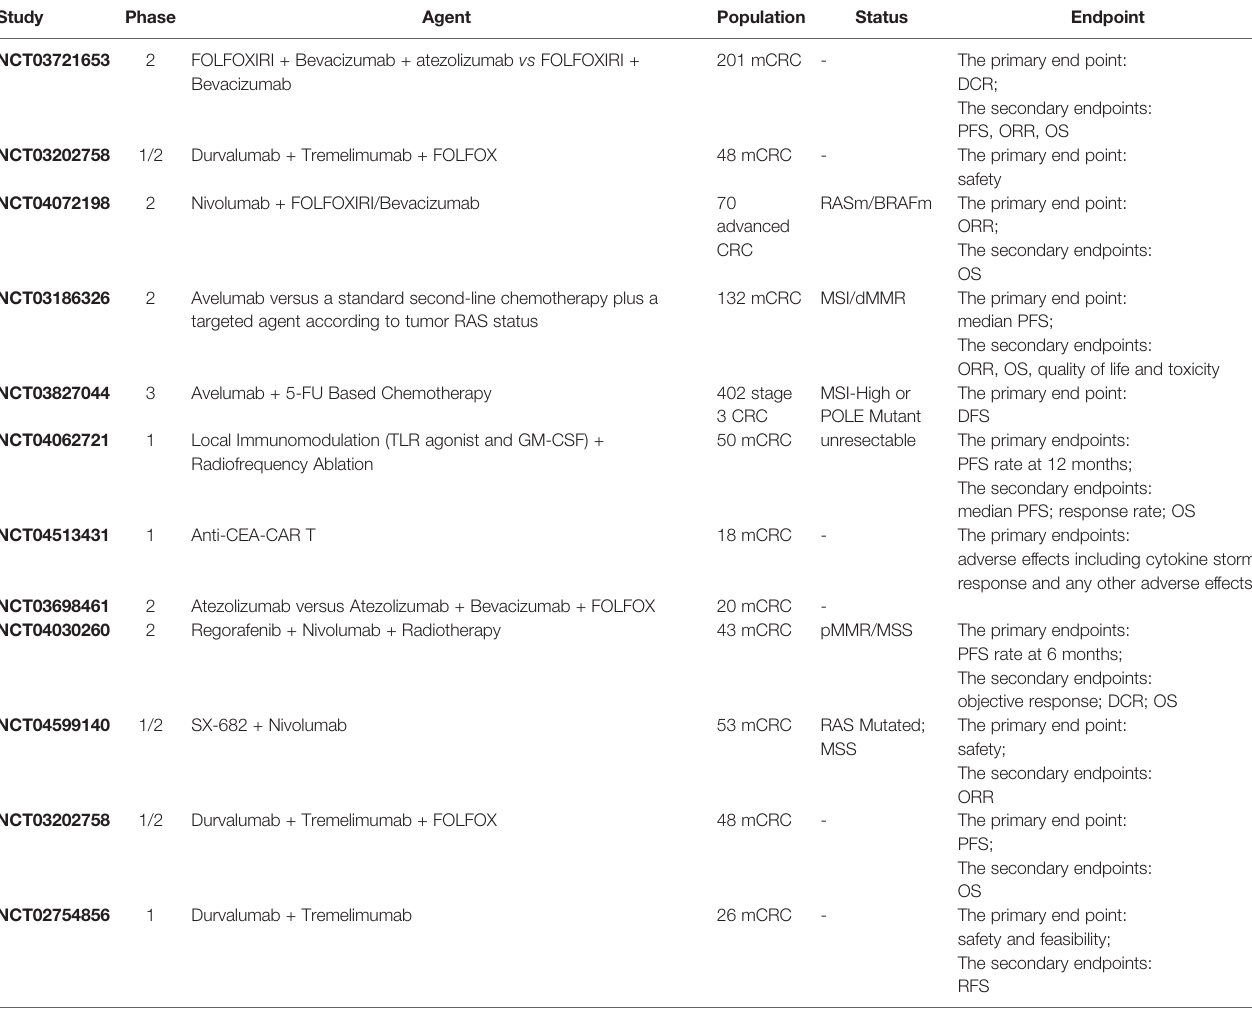
TABLE 3 | Ongoing or Future Clinical Trials of Immunotherapy for